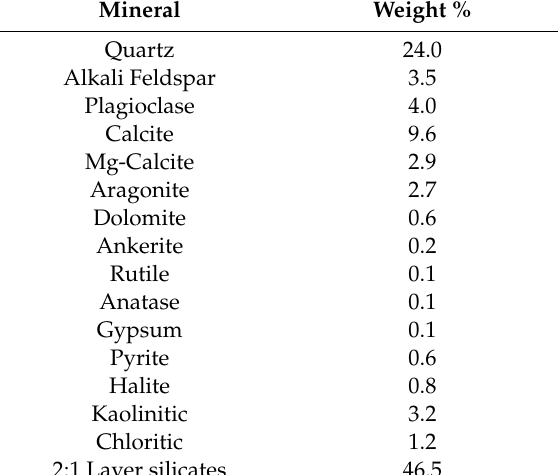
Table 1. The composition of clay analyzed by the X-ray di ff raction technique.